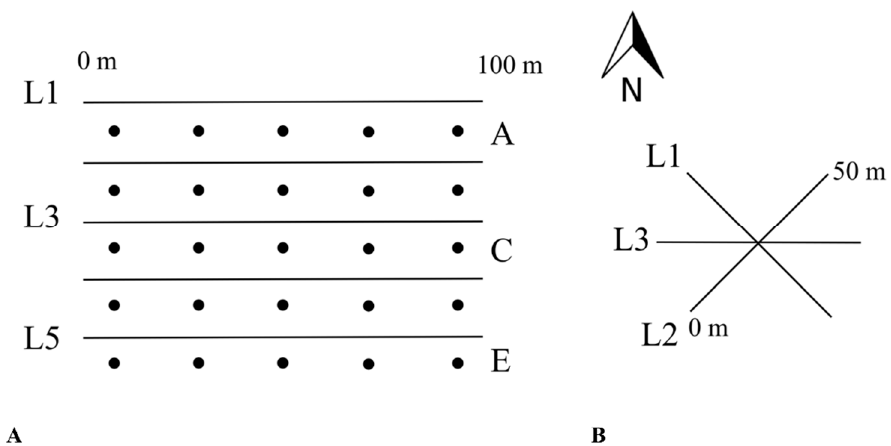
Figure 2. Plot design for ( A ) 100 m × 100 m quadrat and ( B ) 50 m or 100 m sub-plot. Tracing Radiation and Architecture of Canopies (TRAC) measurements were made along the east-west 100 m transects (lines) and the 45° and 135° 50 m transects (lines) for both the quadrat and the sub-plot. Hemispherical photographs were captured at 20 m intervals (dots) within each quadrat and at the 0, 25, and 50 m marks of the sub-plot transects.